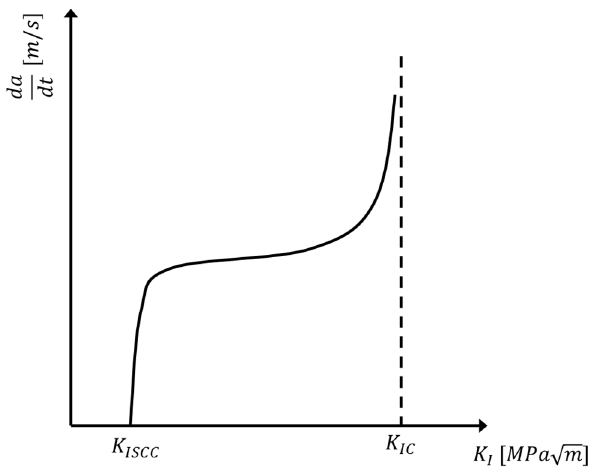
Figure 10. Relation between the stress intensity factor and the crack growth rate. Circuit n.2 is characterized by the presence of the inhibitor. The main differences between Circuits n.1 and n.2 are described in the following